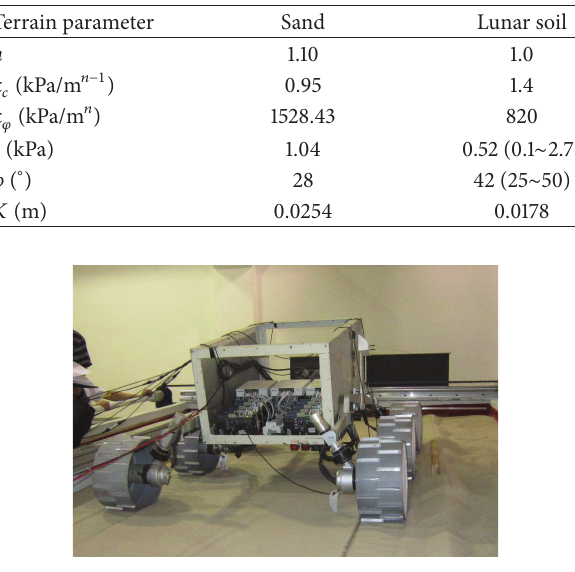
Figure 2: Photograph of six-wheel robot climbing loose sloped terrain in an